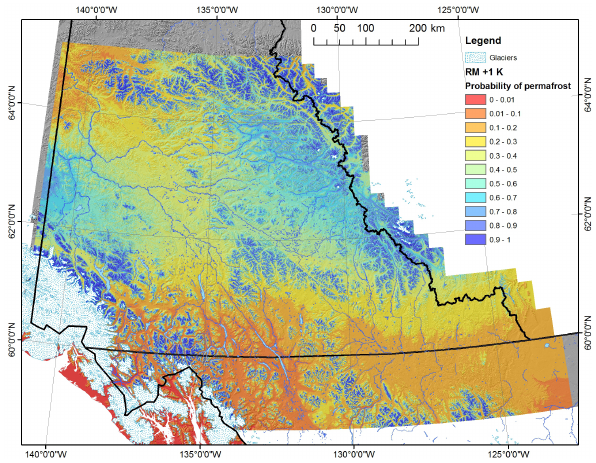
Fig. 6. Regional model permafrost probability map under a + 2K climate change scenario. Permafrost underlies 24% of the region under this scenario.